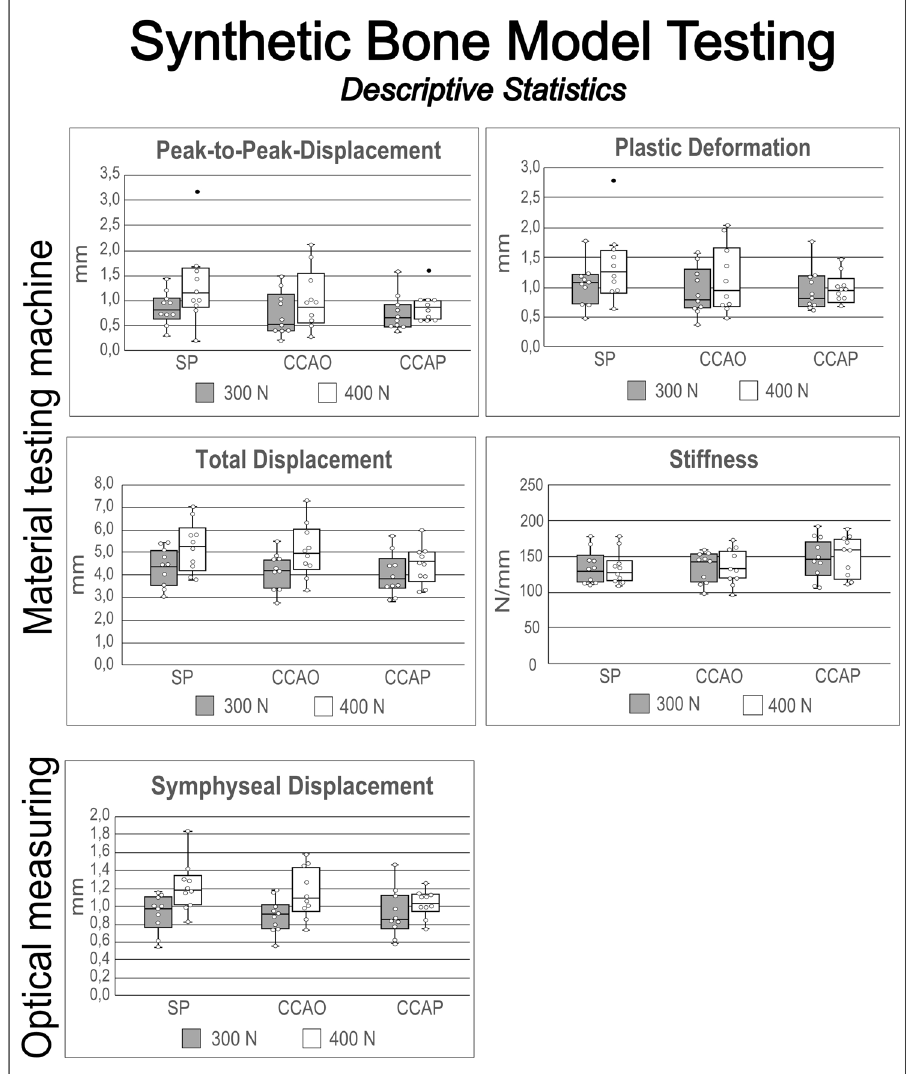
Fig. 4 Results of the synthetic bone model biomechanical testing - box plots ( N = 10). The material testing machine generated a load – displacement curve from which peak-to-peak displacement, plastic deformation, total displacement, and stiffness were measured under two different cyclic load levels. The optical system measured changes in separation of the pubic branches (symphyseal displacement). White dots = individual data points. Black dots = outlier. Lines in the box and whisker plot = error bars are the 95% con fi dence interval, the bottom and top of the box are the 25th and 75th percentiles, and the line inside the box is the 50th percentile